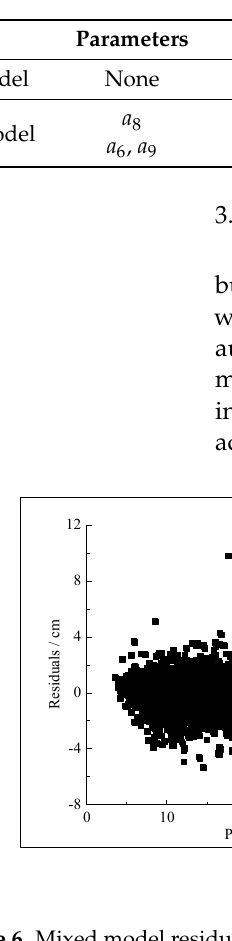
Table 8. Comparison of the mixed models with different random effect parameters.